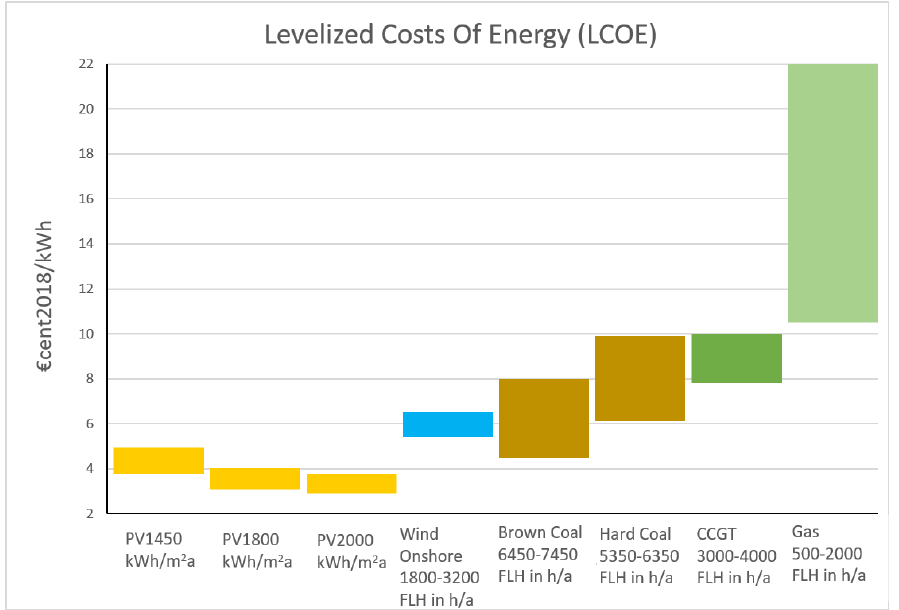
Figure 1. Levelized Costs of Electricity. Renewable Energy Technologies. March 2018. Fraunhofer ISE [1]. FLH in h/a refers to the annual full load hours per annum.